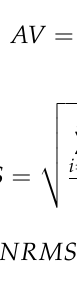
( f ) Figure 16. Five calibration points set by five wooden blocks with different heights. ( a ) Wooden blocks used to set bending angles; ( b ) Bending angle is 0 ° ; ( c ) Bending angle is 21.53 ° ; ( d ) Bending angle is 48.07 ° ; ( e ) Bending angle is 72.25 ° ; ( f ) Bending angle is 96.18 ° .